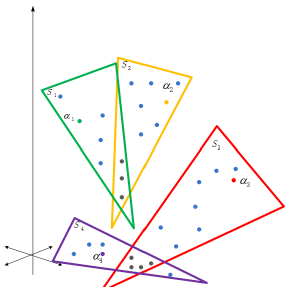
Figure 4: The geometrical illustration of incorrect local sub- space estimation with sparse neighbors.